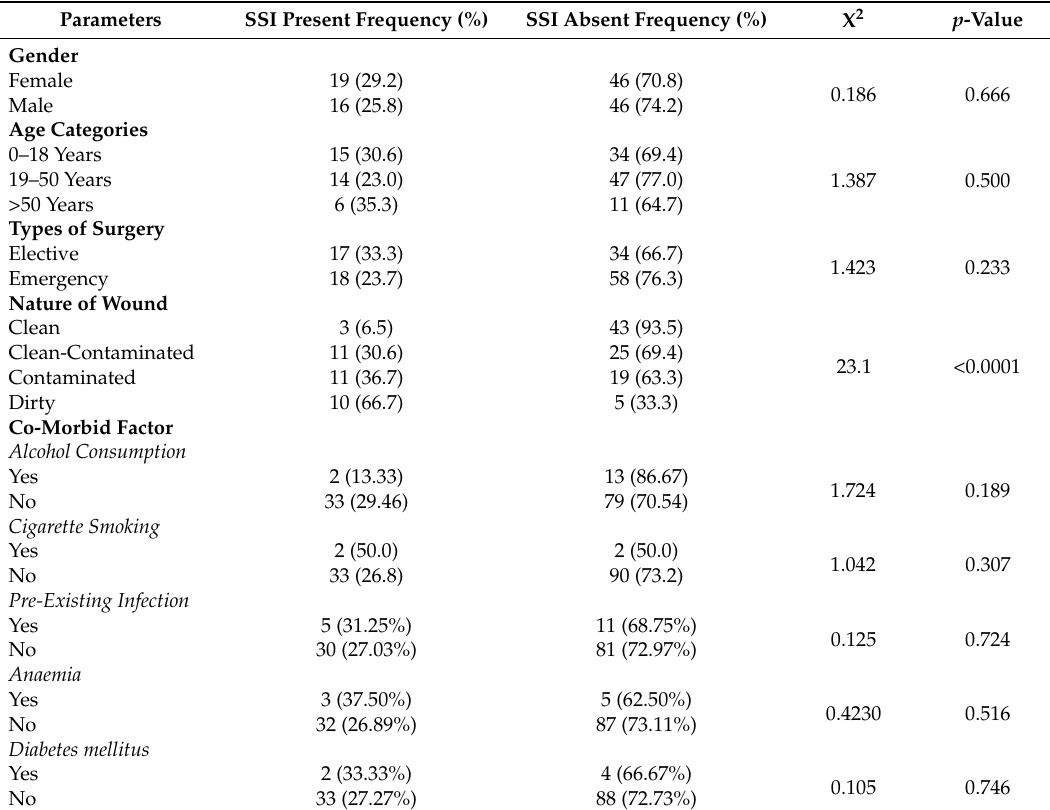
Table 1. Relationship between various patients and clinical parameters and incidence of surgical site infection